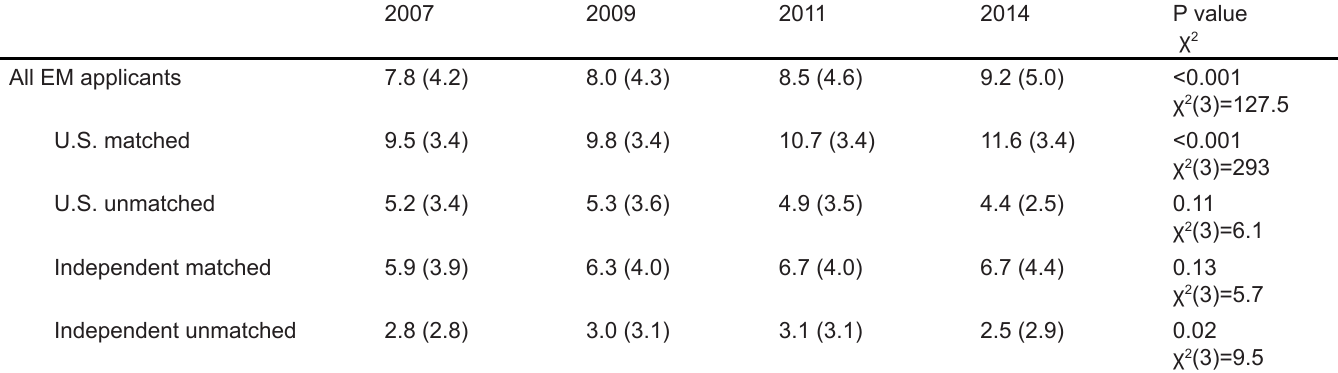
Table 3. Trends in numbers of programs ranked. Data are presented as means (standard deviation).